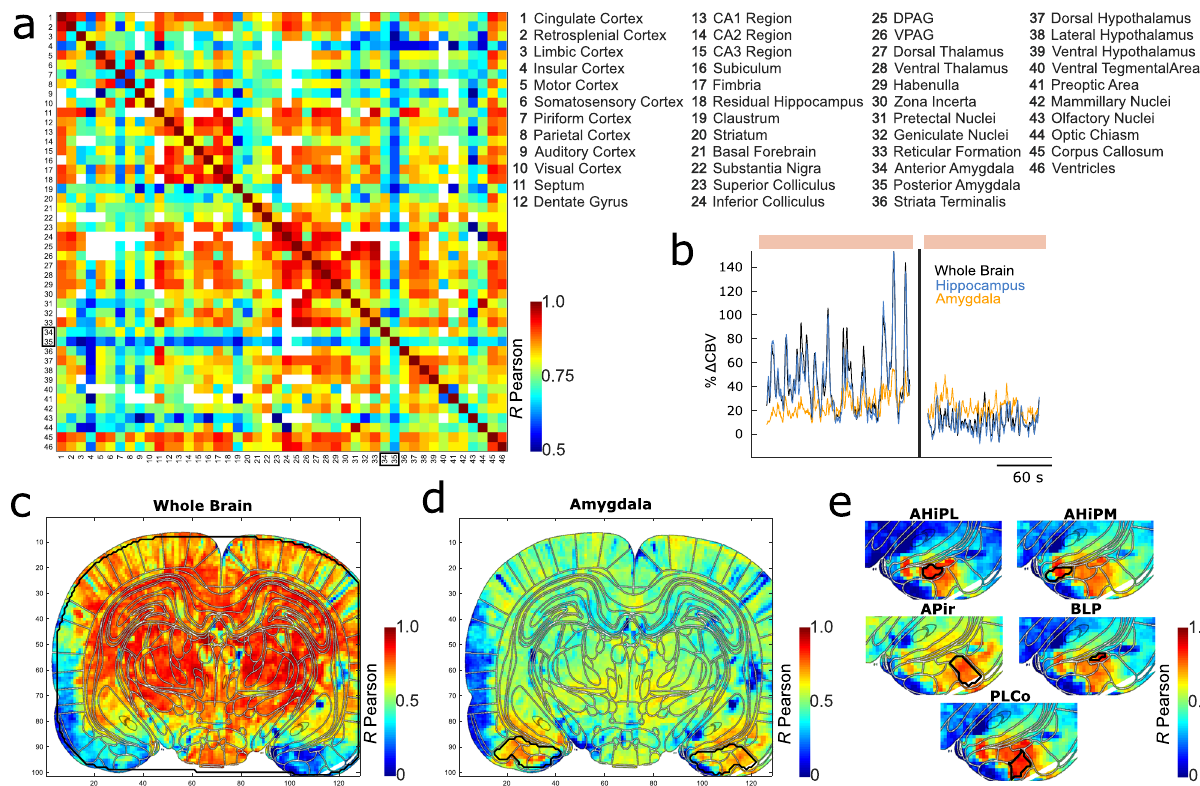
Fig. 5 Disconnection of the amygdala and sub-structures from the rest of the brain during REMS. a Connectivity matrix showing in color the average cross-correlation between the 46 different brain regions and nuclei (legend on the right) across all recordings and in all animals ( N = 3 animals, 72 recordings) (see Supplementary Fig. 7 to have the number of recordings per pixels). White pixels correspond to cross-correlation couples where the number of recordings was either non-existent (because the two brain regions were not present on the same plane) or inferior to 5. Boxes highlight anterior and posterior amygdala. b – e Example of one speci fi c recording. b CBV dynamics of the entire brain (black), the amygdala (yellow) and the hippocampus (blue). The colored patches on the background represent REMS. The dynamics are represented as an averaged value of the percentage of CBV compared to the baseline for each region. Note how the CBV changes dynamics between the fi rst part of this REM episode and the second one: the fi rst part has both a tonic and phasic component while the second part presents only a tonic component. The amygdala keeps the same tonic activity from the fi rst part to the second while the rest of the brain (black) has a slightly lower CBV in the second part. c , d Pixel correlation maps with respectively, the ‘ Whole Brain ’ ( d ) and the ‘ Amygdala ’ ( d ) as seeds (highlighted in black). Note how the amygdala is not correlated with the rest of the brain in c and correlated only with itself in d . e Correlation map details for 5 different nuclei of the amygdala as seeds. For each correlation map, the highest possible correlation per pixel is represented (R max ). Atlas images adapted from The Rat Brain in Stereotaxic Coordinates: Compact, Paxinos G. and Watson C., Copyright (2017), with permission from